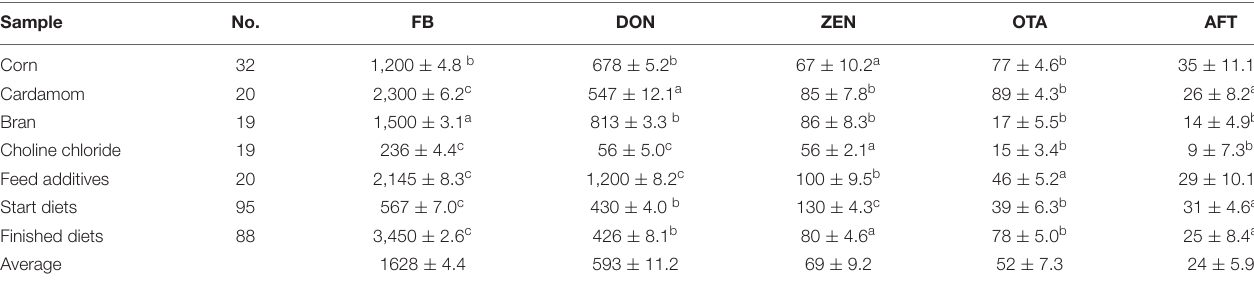
TABLE 2 | Average residues of FB, DON, ZEN, OTA, and AFT in feedstuffs and feeds ( µ g/kg).